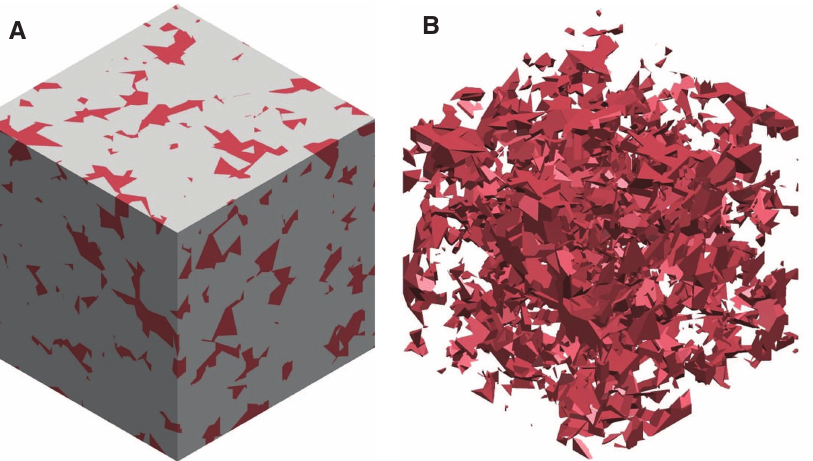
Figure 4: Three-dimensional microgeometry containing 6% Co and cobalt islands: (A) isometric view and (B) detailed view on the cobalt phase.